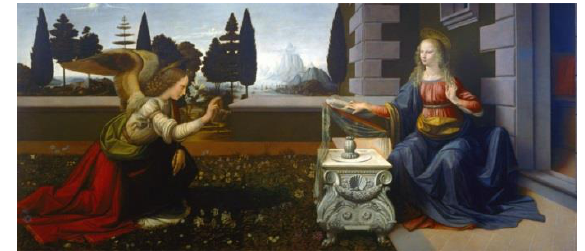
Fig. 9 Annunciation (Leonardo da Vinci, 1472-1475) In this context, the way to acquire a correct perspective is shown by a comparison between a flat byzantine representation (Fig. 10) and an attempt to draw the perspective in Gothic pictures (Fig. 11).